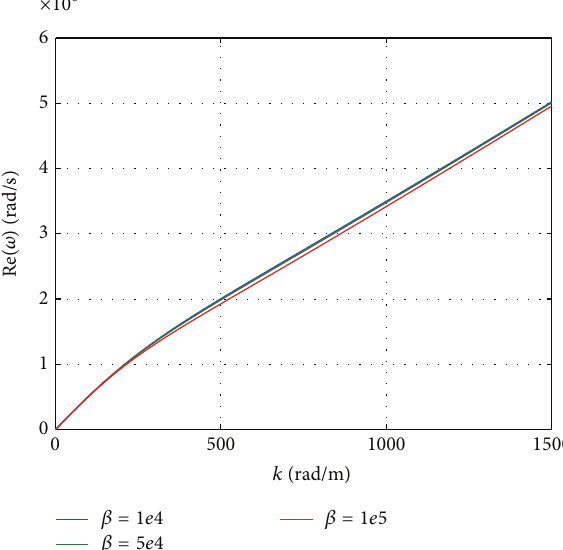
Figure 3: Dispersion curve for a rod using the Rayleigh-Bishop theory, compared to the classical and exact theories. Figure 4: Angular frequency (real part) versus frequency for three damping coefficients 𝛽 .